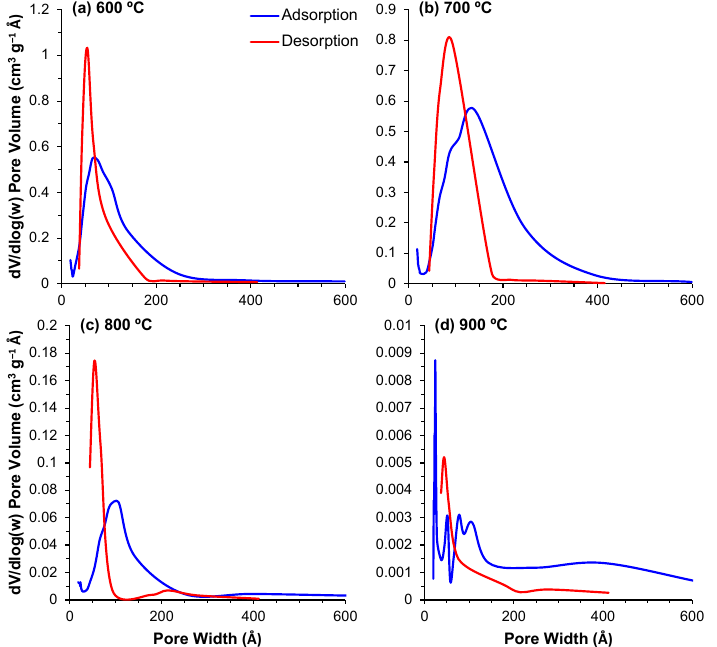
Figure 6. ( a – d ) Contribution of the different pore sizes to the overall pore volume for the powders calcined at temperatures of 600–900 °C.